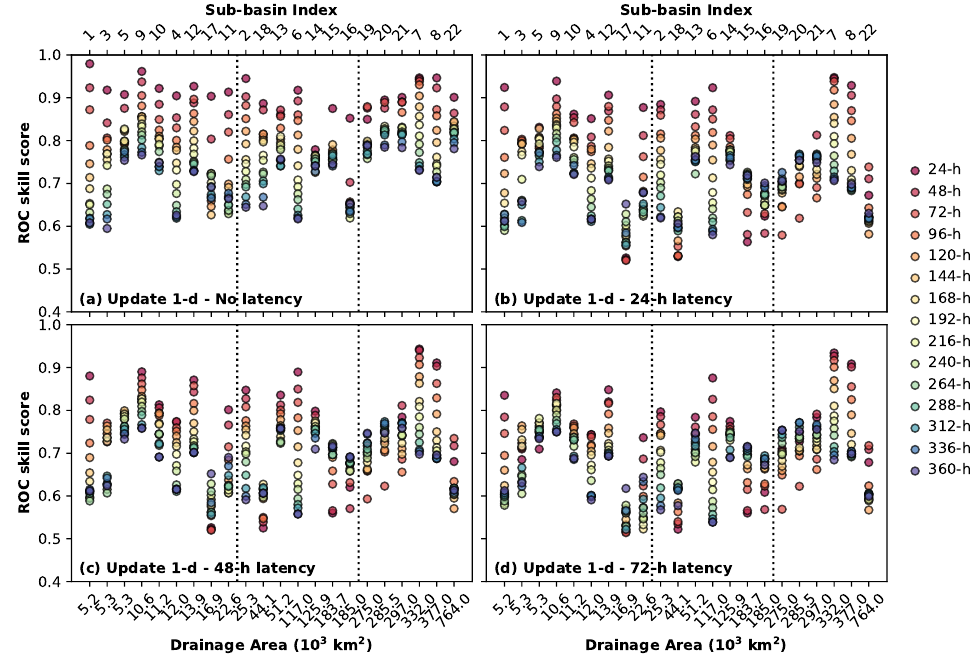
Figure 4. ROC skill score for 22 sub-basins of the Tocantins-Araguaia Basin for 15 lead times as a function of the drainage area for streamflow with a probability level of 0.9. MHD-INPE update every 1 d and ( a ) no latency, ( b ) 24 h latency, ( c ) 48 h latency, and ( d ) 72 h latency to the ECMWF ensemble. The vertical dotted lines divide the drainage area into small, medium, and large